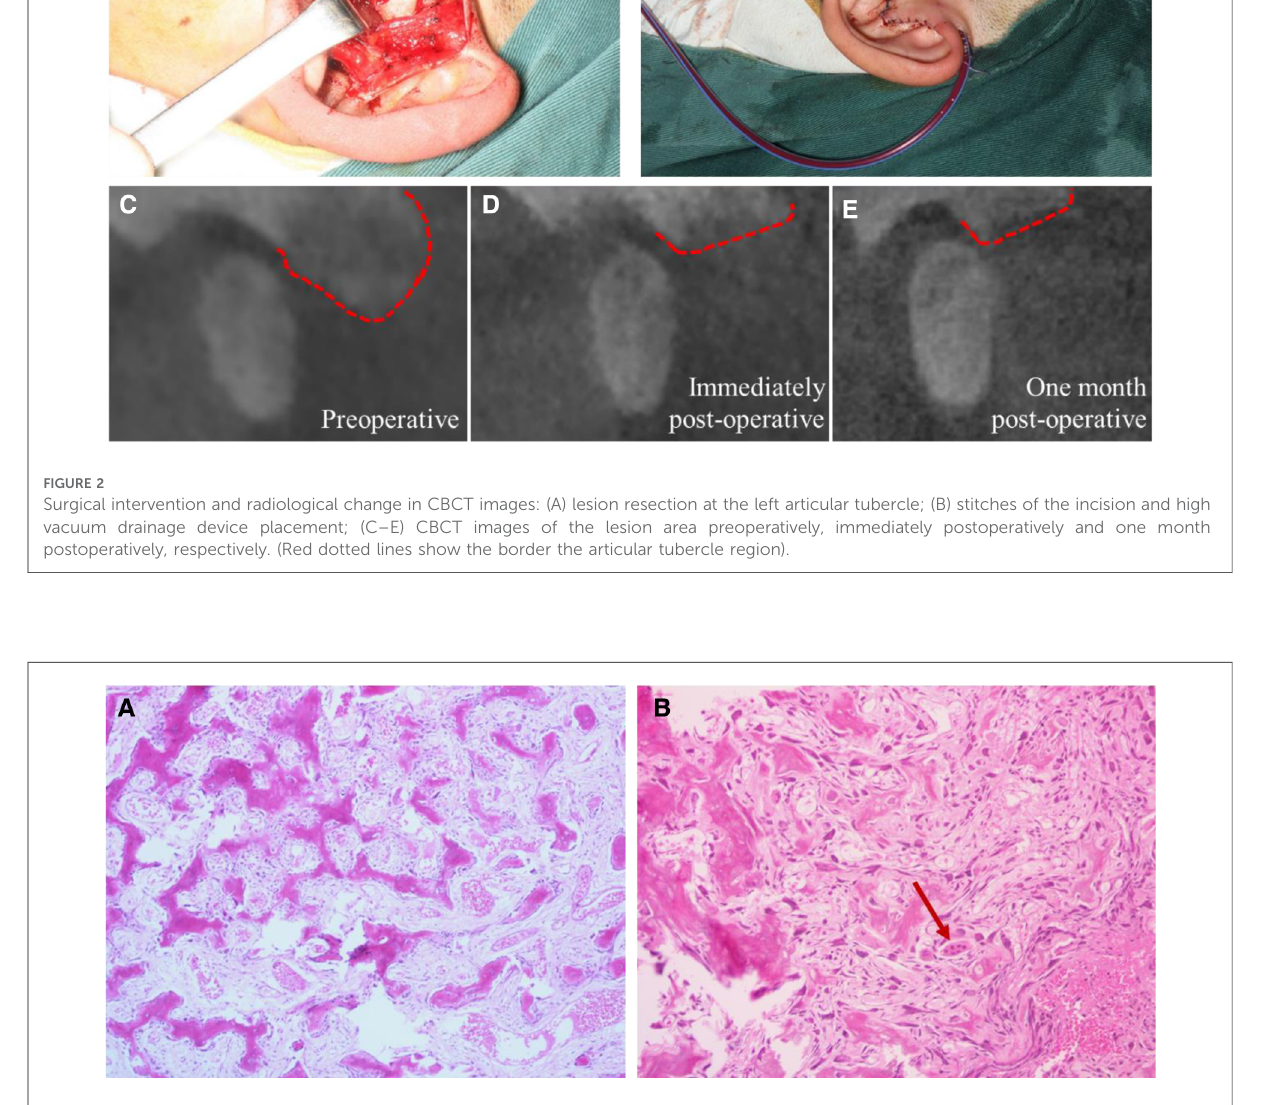
FIGURE 3 Histopathological features (H&E staining): (A) immature trabeculae rimmed by osteoblasts; (B) giant cells with multiple dense nuclei and cellular atypia can be found. H&E, Hematoxylin and